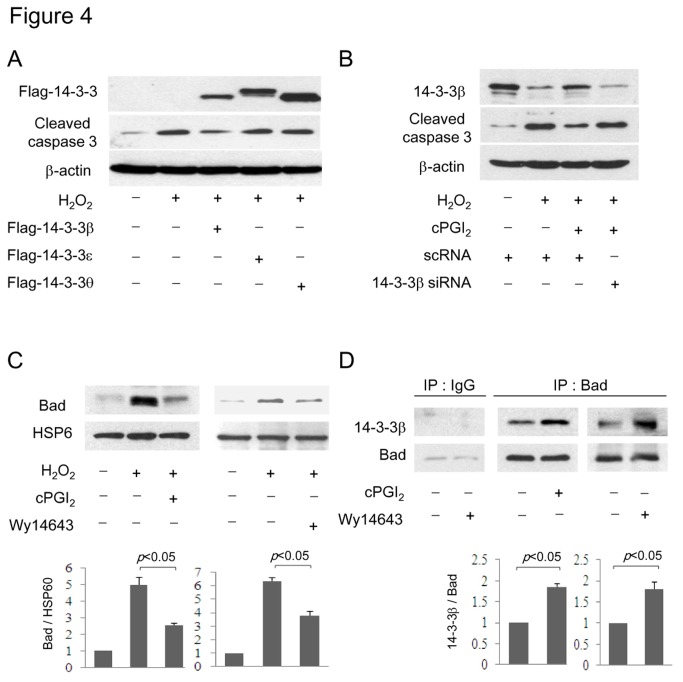
14-3-3β protects against H2O2-induced apoptosis by sequestering Bad.(A) A-10 cells were transfected with Flag-tagged 14-3-3β, ε or θ vectors. Following H2O2 treatment, cells were lysed and cleaved caspase 3 was determined. (B) Cells were transfected with 14-3-3β siRNA or control scRNA. The transfected cells were treated with cPGI2 and H2O2. 14-3-3β and cleaved caspase 3 were analyzed by Western blotting. (C) Cells were treated with cPGI2 (100 µM) or Wy14,643 (50 µM) prior to H2O2 treatment. Mitochondrial fractions of VSMCs were isolated and Bad was analyzed by Western blotting. Heat shock protein 60 (HSP60) was concurrently measured as mitochondrial marker. (D) Cells were treated with cPGI2 (100 µM) or Wy14,643 (50 µM) and then lysed. Lysates were immunoprecipitated with Bad antibody or control IgG. 14-3-3β and Bad in the immunoprecipitates were determined by Western blotting. Each error bar denotes mean±SEM and all blots are representative of n≥3. NS denotes statistically non-significant.